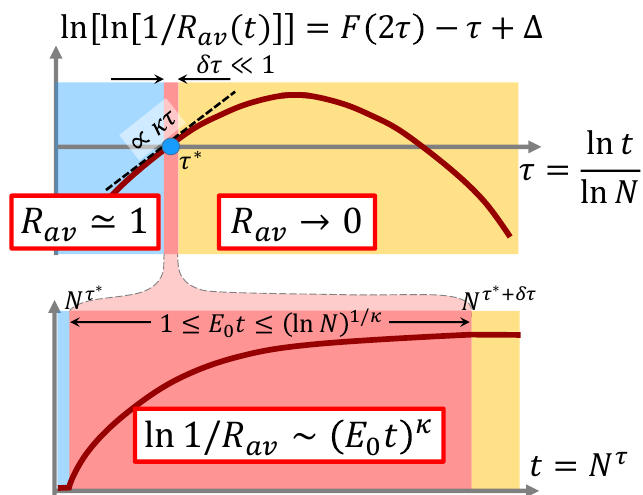
( t ) (cid:39) 1 − N − c , av